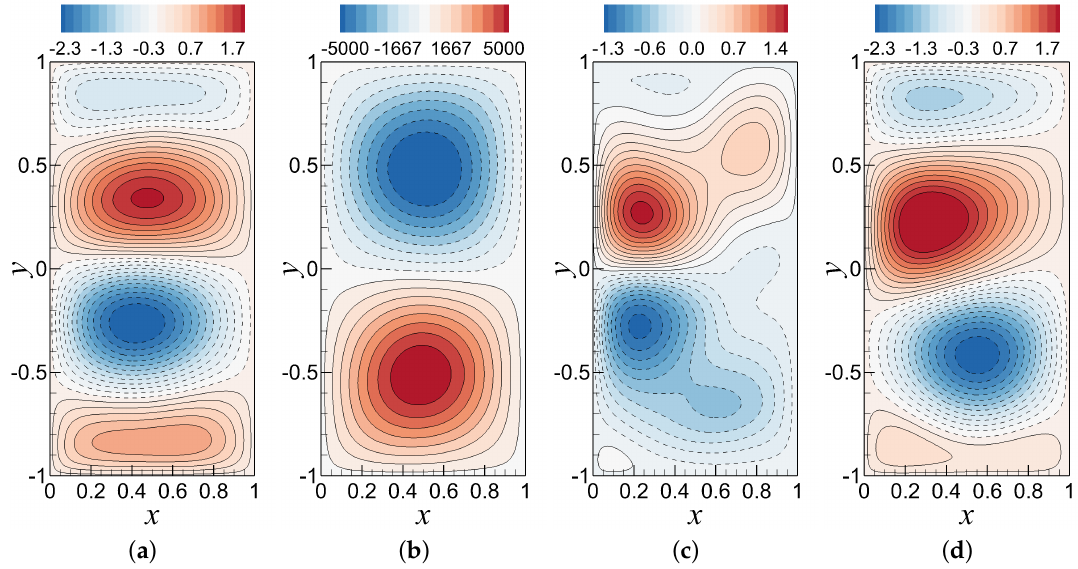
Figure 25. Out-of-sample forecast of mean stream function by: ( a ) FOM; ( b ) ROM-GP; ( c ) ROM-ANN; and ( d ) ROM-H using R = 10 POD modes. Predictive performance is shown for Re = 200 while the training has been performed using the data generated at Re = 100. This figure clearly illustrates that the ROM-H model has successfully predicted the FOM solution while the ROM-GP model prediction is unphysical and the ROM-ANN prediction is not as accurate as the ROM-H